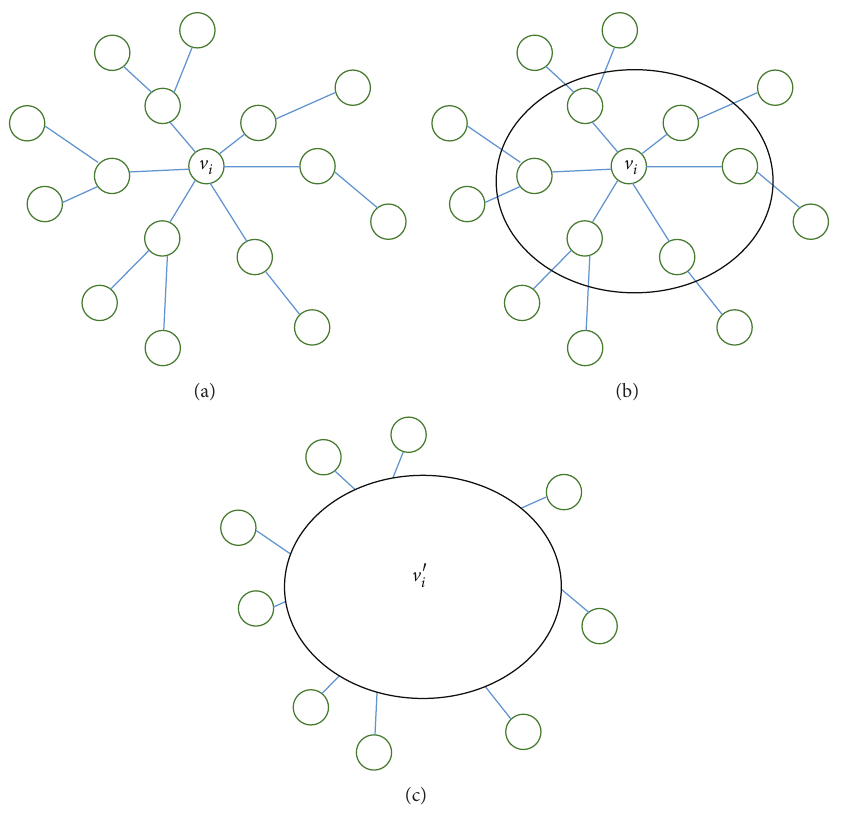
Figure 7: Illustration of node